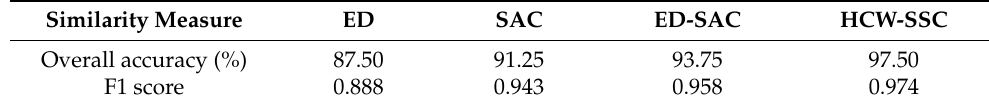
Table 3. Overall accuracy of each similarity measure based on standard spectral libraries (Euclidean distance (ED), spectral angle cosine (SAC), Euclidean distance–spectral angle cosine (ED-SAC), and a new hybrid changing-weight classification method with a filter feature selection (HCW-SSC)). Similarity Measure